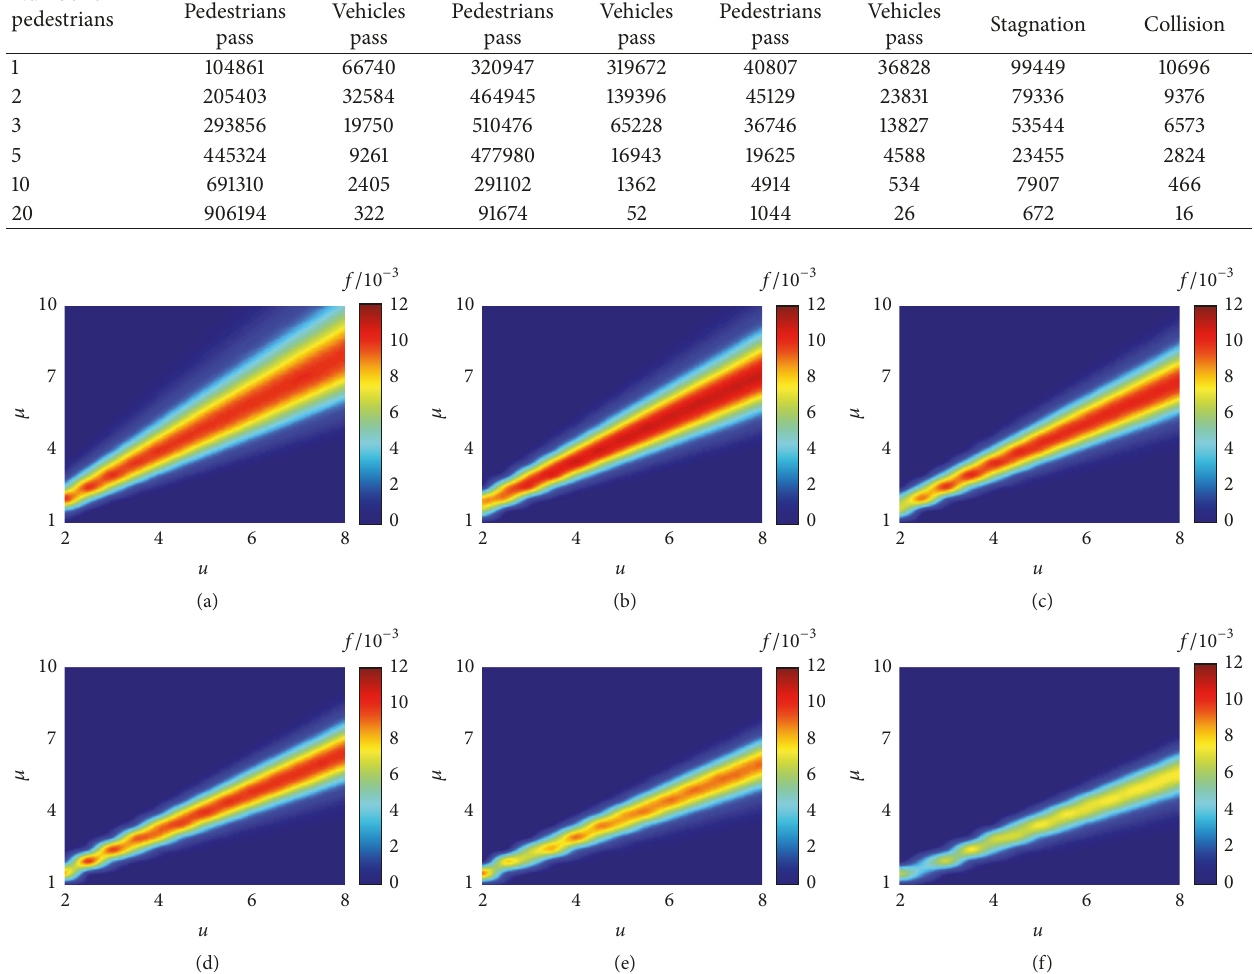
Table 1: Number (out of the sample of 1 million) of pedestrians/vehicles passing through the intersection under different modes ( 𝜇 = 4 s, 𝑢 = 4 s). Number of